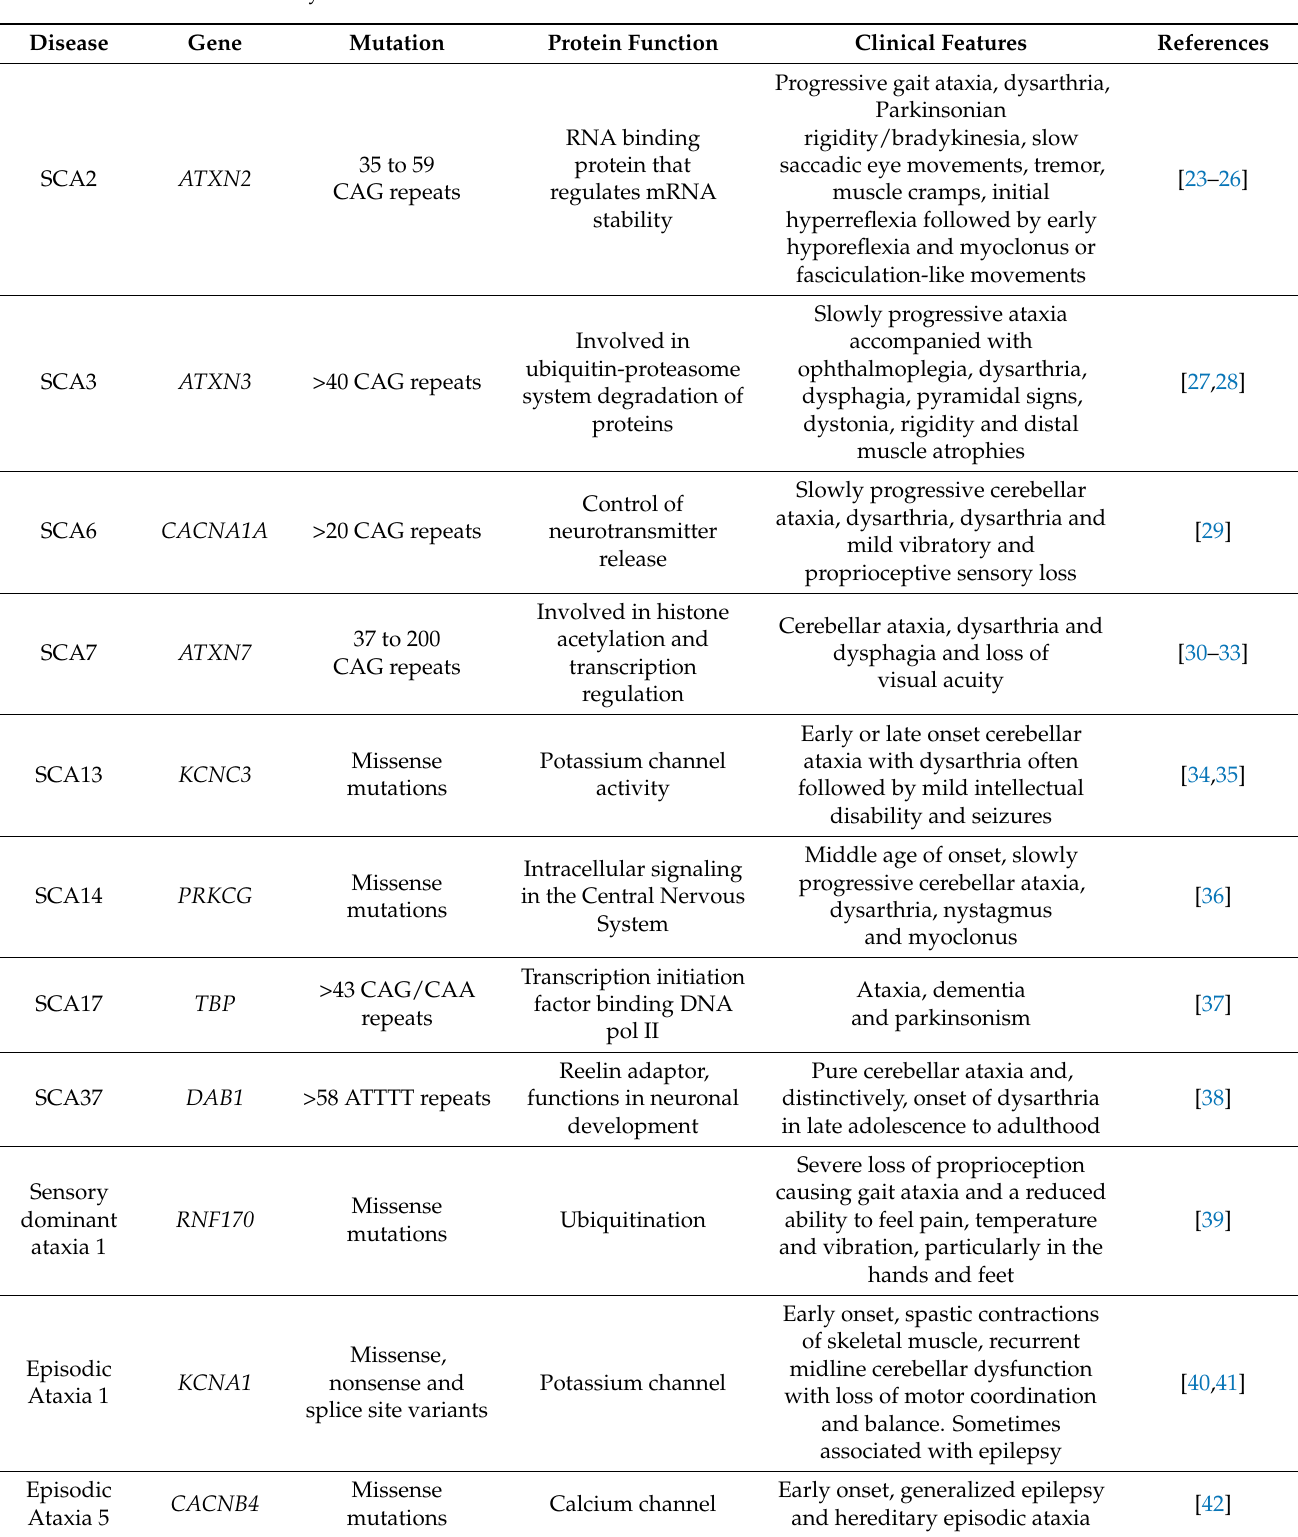
Table 1. Summary of molecular mechanisms and clinical features of the ataxias discussed in this article.